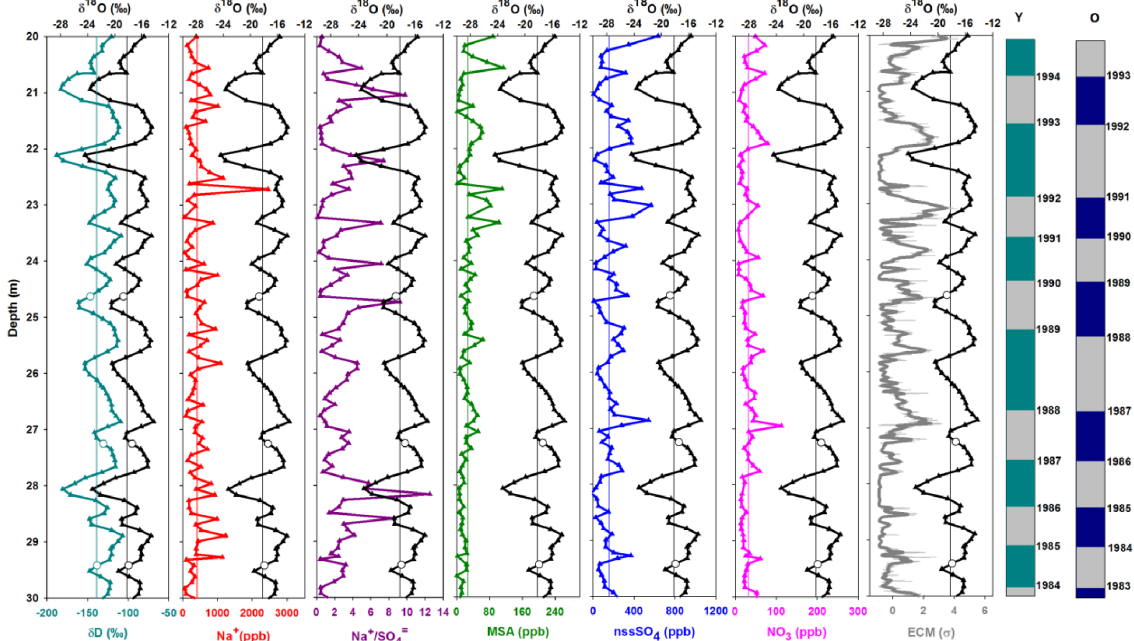
Figure 3. A 10m-long illustrative example of how variations in stable isotopes ( δ 18 O, δ D), chemical species (or their ratios), and smoothed ECM (running mean, 0.1m) are used to identify annual layers. Coloured bars on the right indicate the annual layer boundaries (middle depth of each period corresponding to above average δ 18 O values) for the youngest (Y) and oldest (O) estimates, with 1-year difference at 20m depth. See Figs. S1 and S2 for the whole profile. White dots in the δ 18 O and δ D profiles indicate thin ice layers identified visually in the core. δ 18 O profiles are shown multiple times to better illustrate correlations between δ 18 O and other profiles.